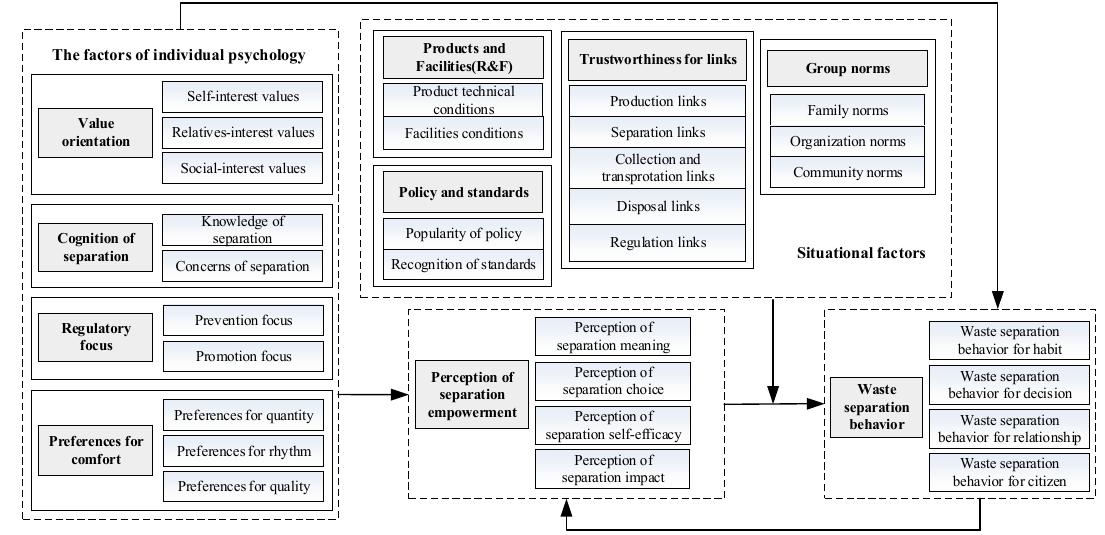
Figure 2. Driving model of urban residents’ waste separation behavior.